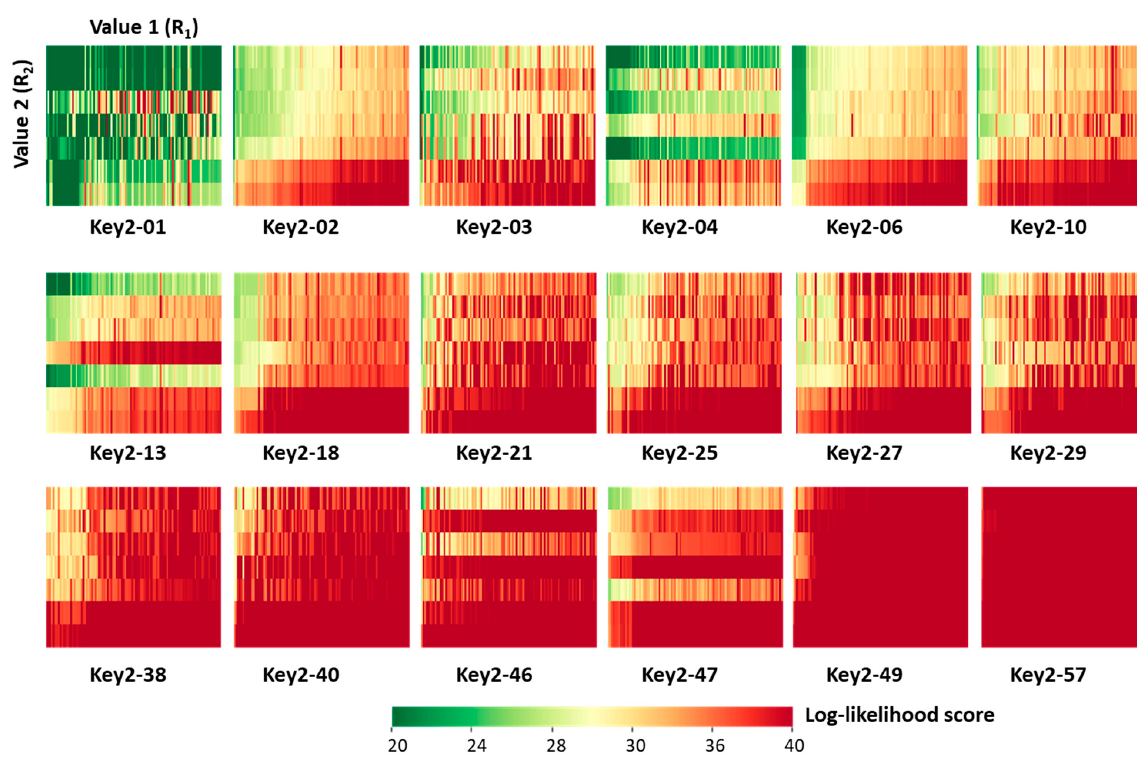
Figure 5. [Value 2 × Value 1] matrix for each of the 18 prioritized Key 2 fragments. The matrix cells represented unique ([Key 2 − Value 2] − Value 1) combinations (candidate compounds) color-coded by cumulative log-likelihood scores.